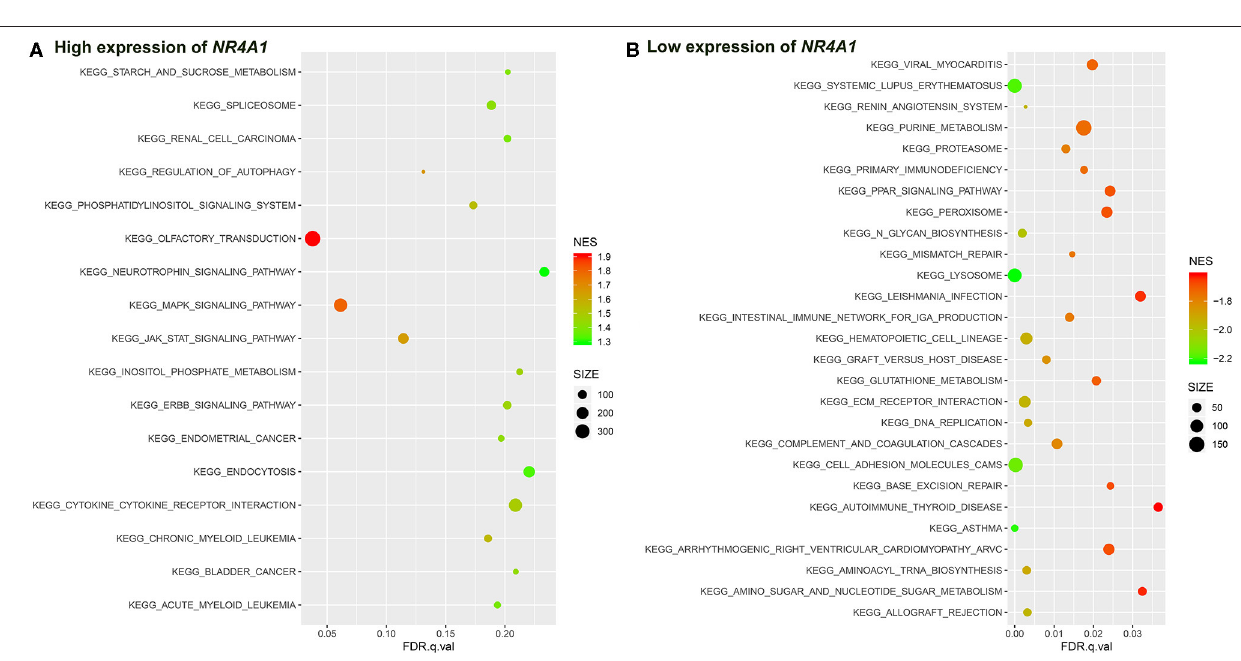
FIGURE 8 | The results of the GSEA on the KEGG pathway. (A) KEGG pathway in the high expression of NR4A1 in AV fistula and (B) KEGG pathway in the low expression of NR4A1 in AV fistula. The size of the node represents the number of genes under the gene set. The color of the node represents the NES of the gene set. The horizontal axis represents the level of q